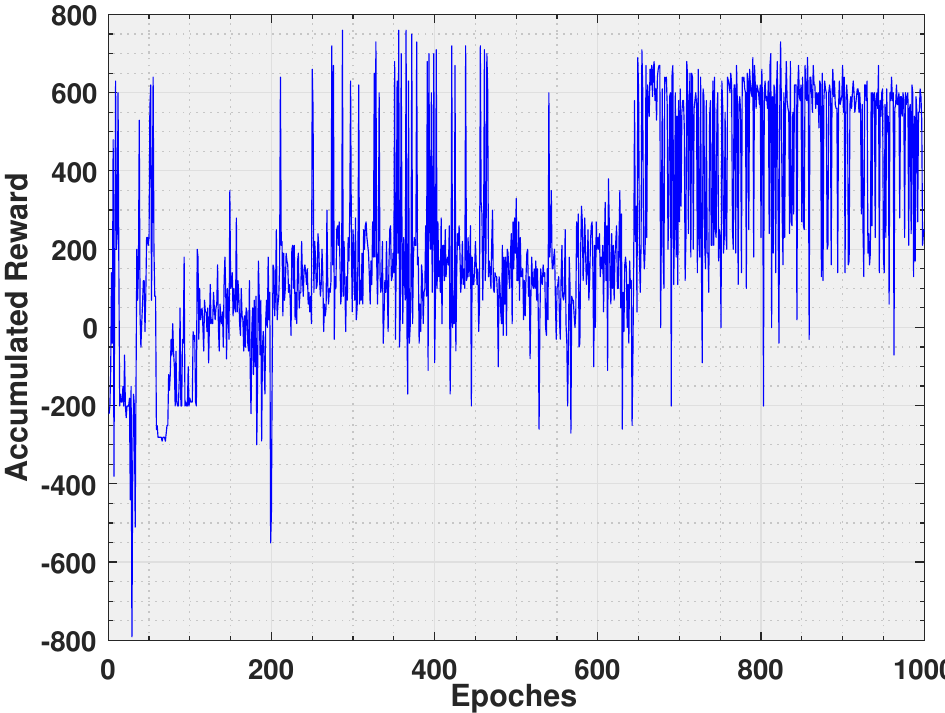
Figure 18. Accumulated rewards for Model 2 decision